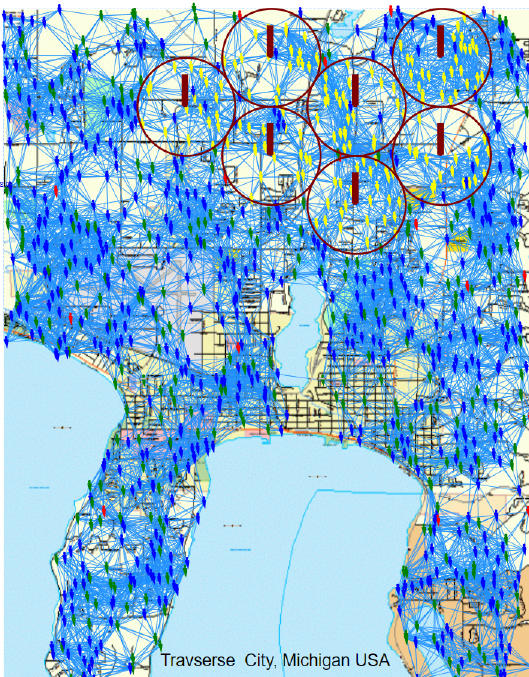
Figure 6. Studied scenario of the Traverse city in Michigan, USA, with 7 gNBs and 15,000 randomly distributed UEs in the AnyLogic ® software. Linked UEs (resp. UE-to-gNB links) represent D2D (resp. traditional) communication possibilities. Dark Red circles represent the gNBs’ covering areas in which the gNBs are at the center. Victim (emergency) devices, relay devices, in-coverage devices, and idle devices are represented respectively by the colors, red, green, yellow, and